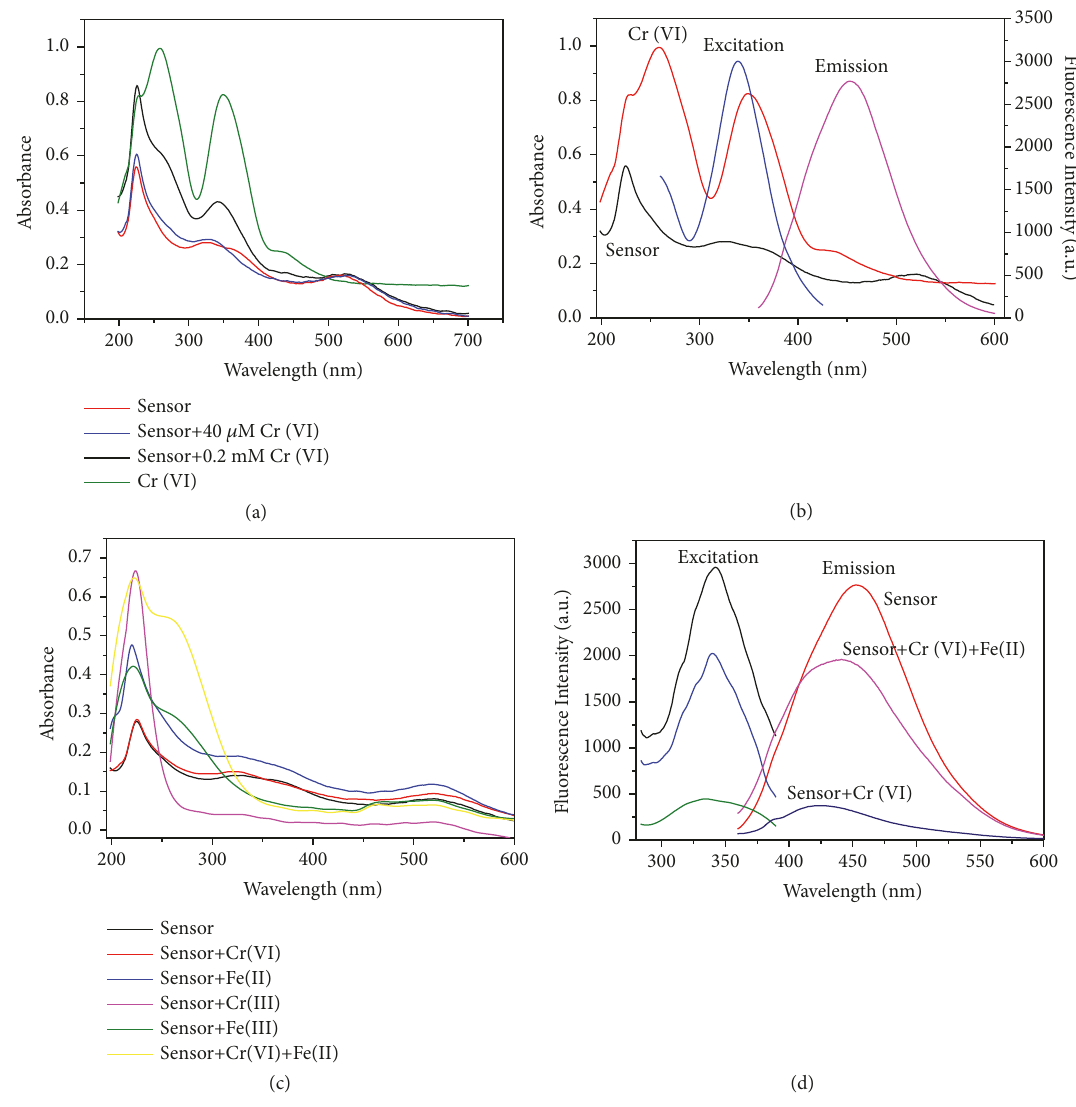
Figure 4: (a) UV-Vis absorption spectra of Cr(VI) and the sensor before and after the addition of Cr(VI). (b) Fluorescence spectra of the sensor and UV-Vis absorption spectra of the Cr(VI) and the sensor. (c) UV-Vis absorption spectra of the sensor before and after the addition of different kinds of species. (d) The excitation and emission spectra of the sensor before and after the addition of different kinds of